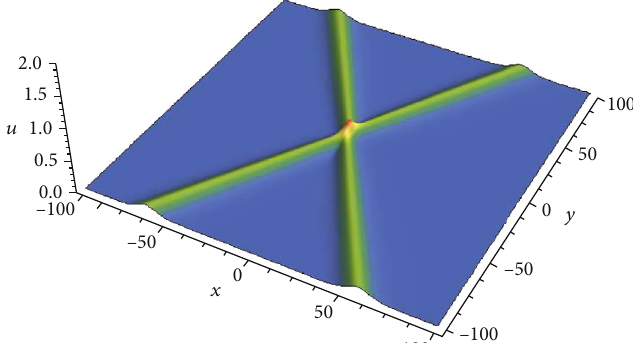
= 1/2 , k = 1/2 , p = 2/3 , 1 2 1